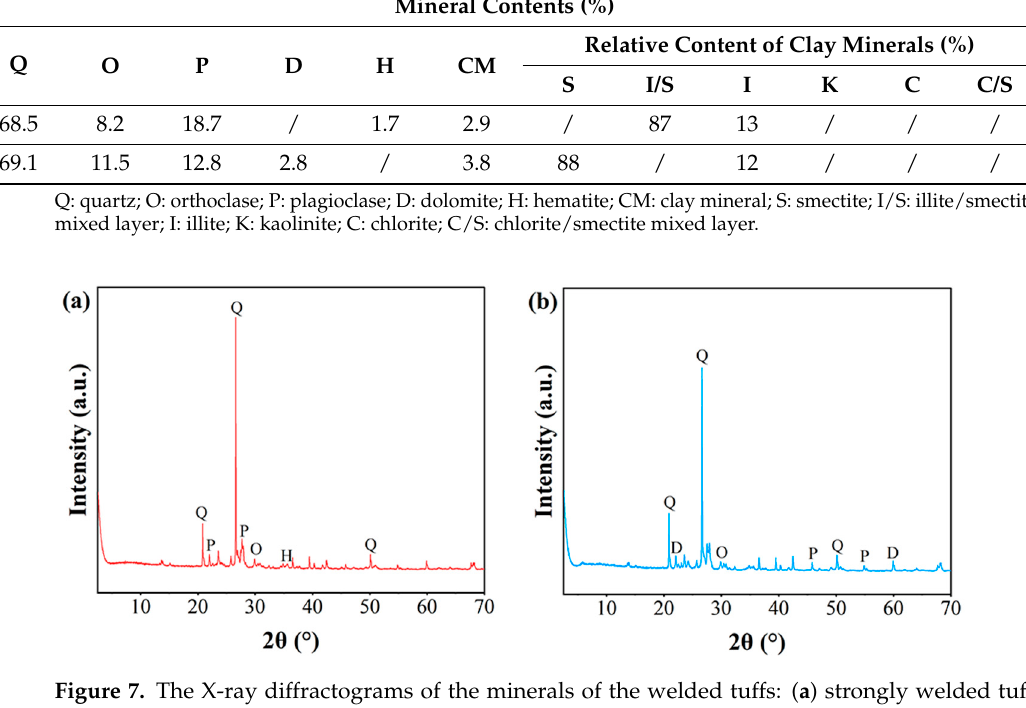
Figure 7. The X-ray diffractograms of minerals of the welded tuffs. ( a ) The strongly welded tuff. ( b ) The weakly welded tuff. Q: Quartz, O: Orthoclase, P: Plagioclase, D: Dolomite, H: Hematite. Table 1. The mineralogical composition of welded tuff.